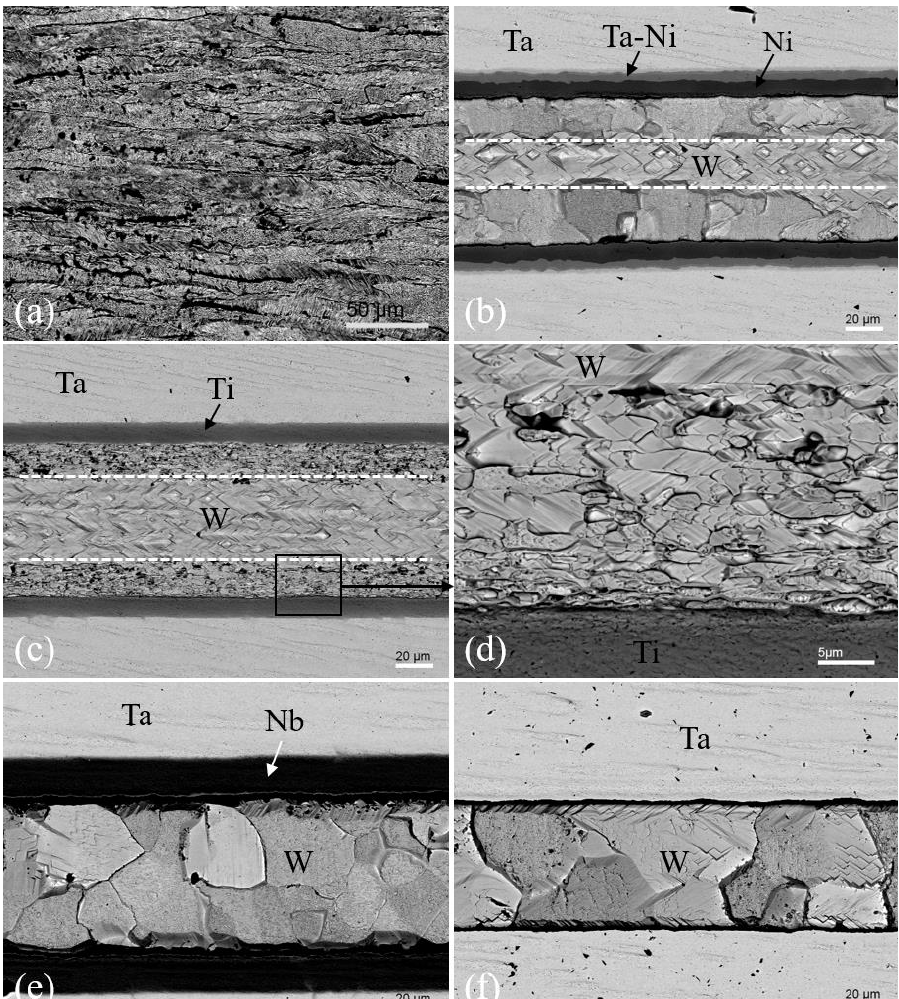
Figure 10. The BSE images of W grain with the e ff ect of di ff erent transition layers, ( a ) the original W grain before SPS, ( b ) W / Ni / Ta, ( c , d ) W / Ti / Ta, ( e ) W / Nb / Ta, ( f ) W / Ta.